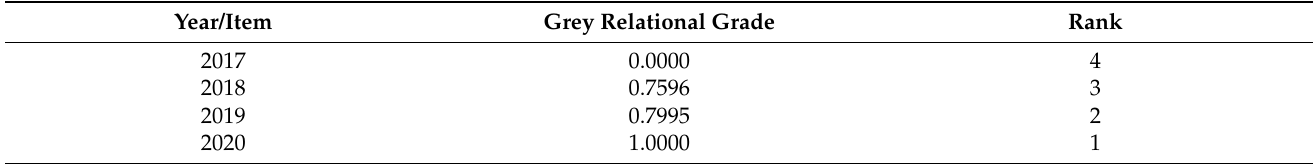
Table 6. Grey relational grade for each year.